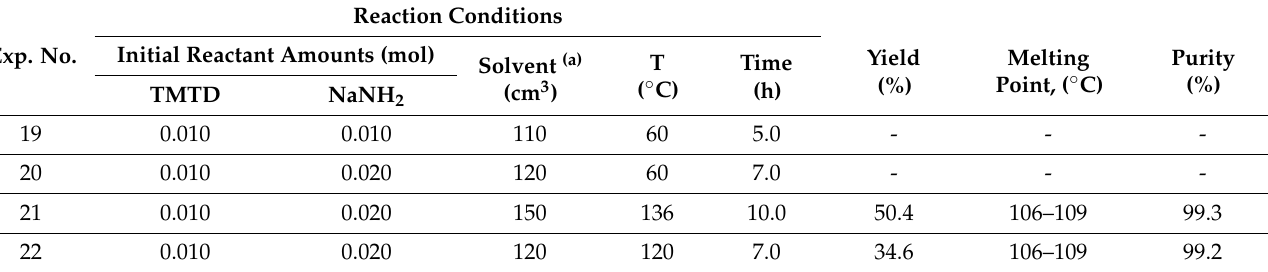
Table 4. Results of TMTS synthesis using an amide